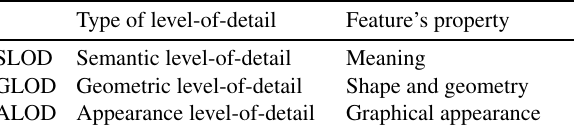
Table 2. Level-of-detail acronyms used in this